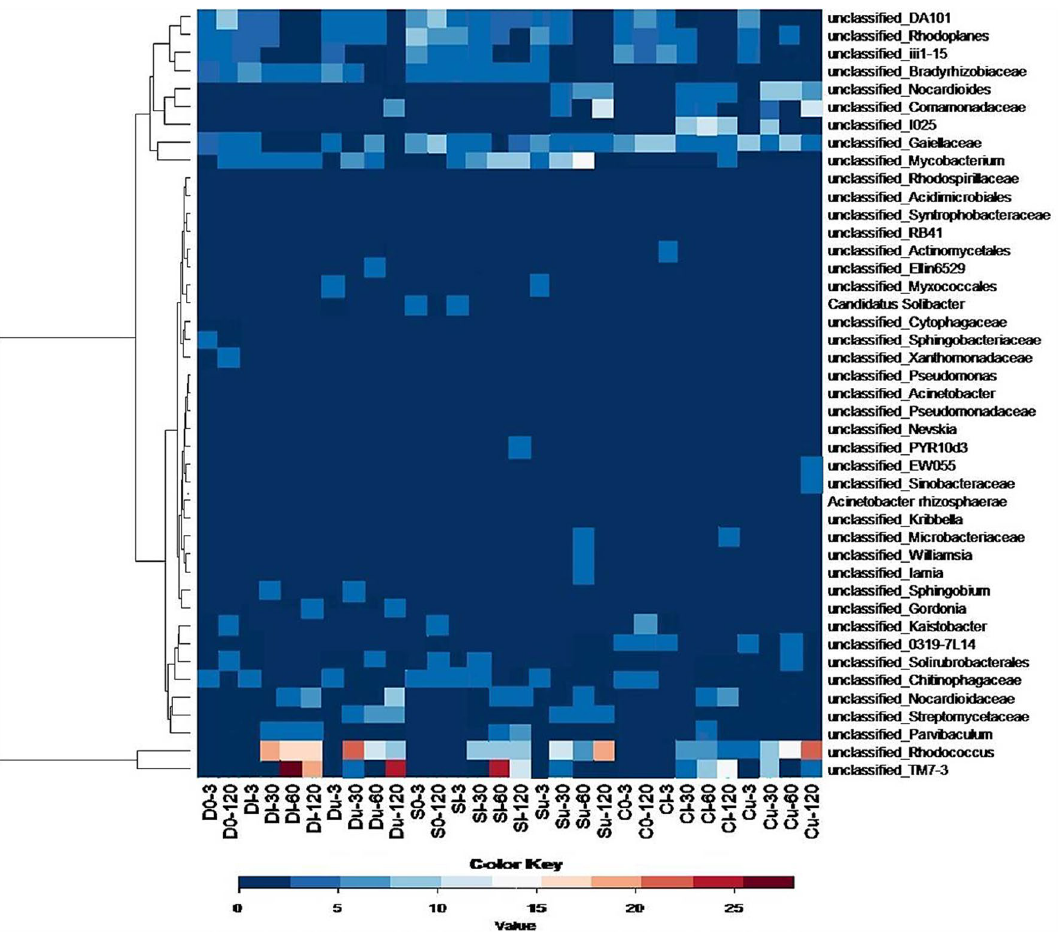
Figure 4. Heatmap of dominant bacterial genera (% relative sequence abundance ≥ 2). Changes are displayed on a relative scale with enrichment in red and depletion in